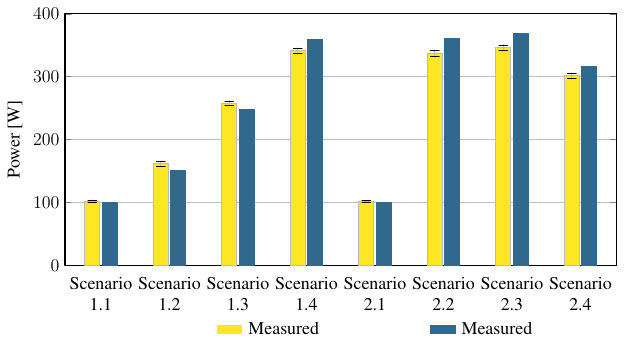
Figure 20. Predicted versus measured total system power losses, Scenarios 1 and 2.